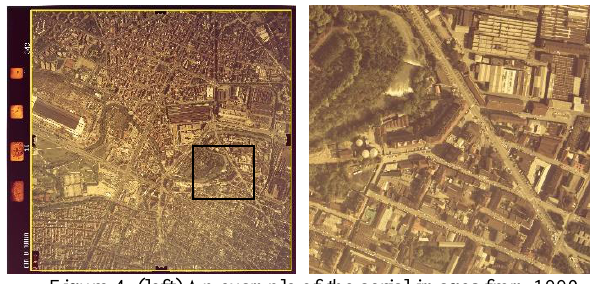
Figure 4. (left) An example of the aerial images from 1990 photogrammetric block and the cropped area in yellow, 23x23cm; (right) A zoomed excerpt of the southern Dora area Bundle block adjustment RMSE